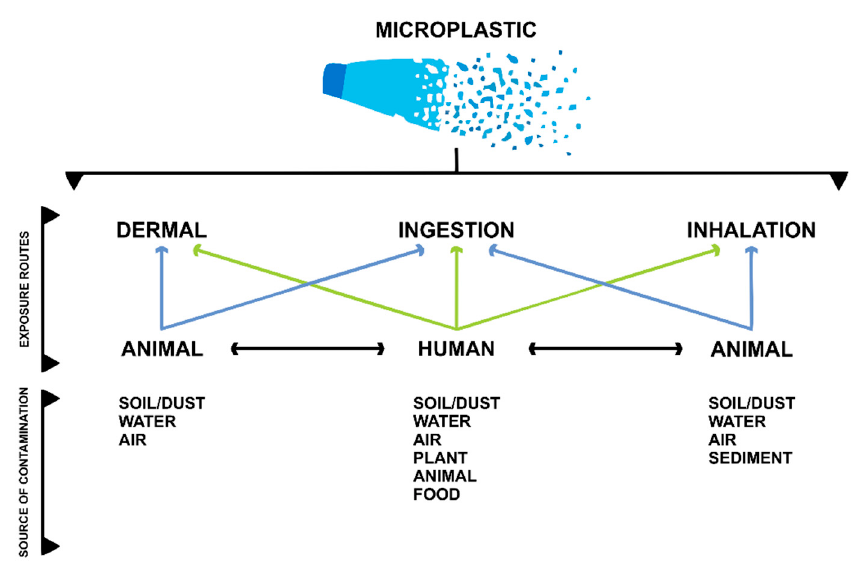
Figure 1. Exposure routes for microplastics in the environment. Modified from Enyoh et al., 2020 [9].